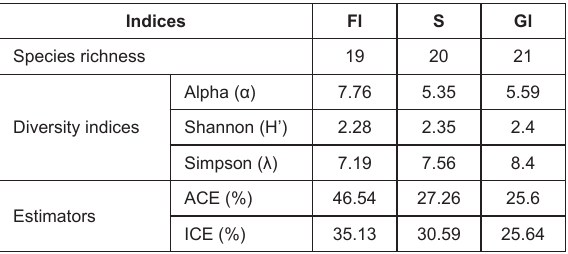
Table 2. Species diversity indices of orthopteroid fauna in Kaziranga National Park, Assam